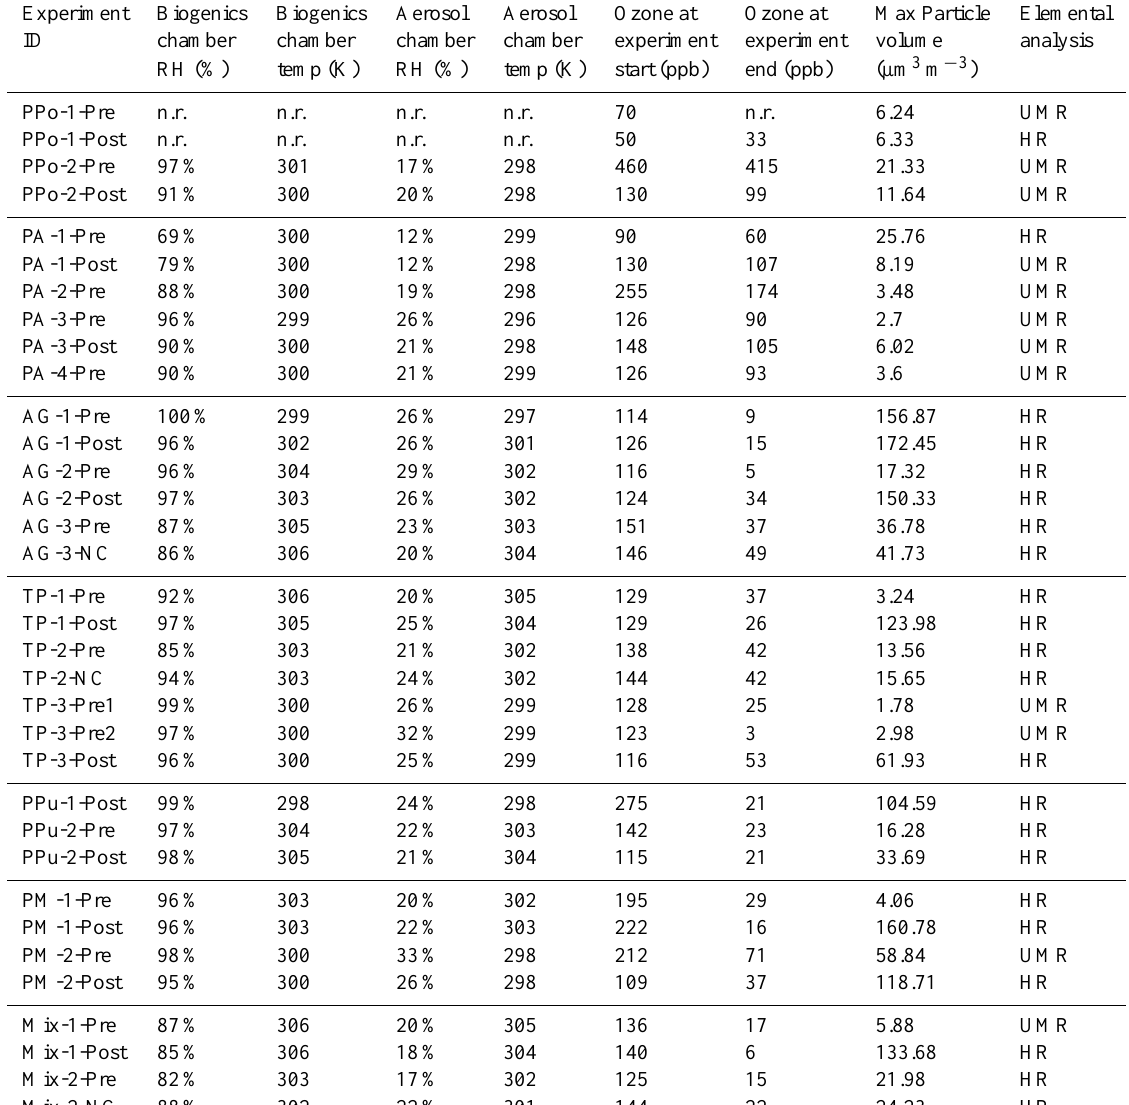
Table 2. Experiment conditions. The n.r. stands for not recorded. Particle volume was calculated from SMPS measurements. Experiment Biogenics Biogenics Aerosol Aerosol Ozone at Ozone at Max Particle Elemental ID chamber chamber chamber chamber experiment experiment volume analysis